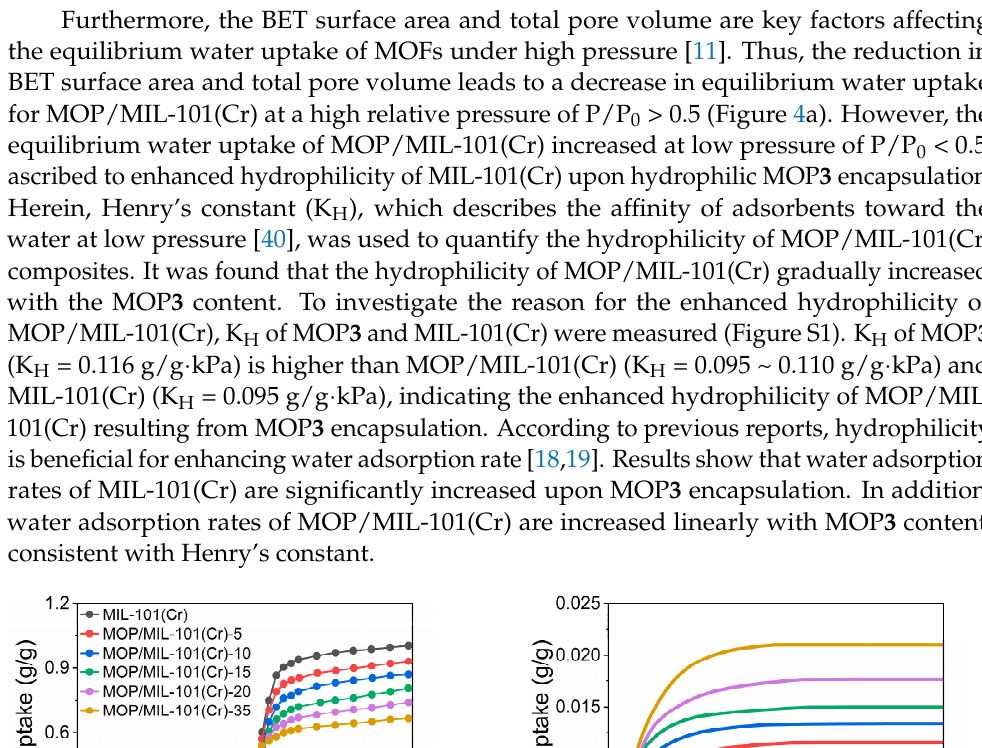
Figure 3. Structural characterization of MOP/MIL-101(Cr) composites. ( a ) SEM images, ( b ) PXRD patterns, ( c ) FT-IR spectra, ( d ) BET surface areas (S BET ) and total pore volumes (V p ), ( e ) Pore size distributions (PSD).